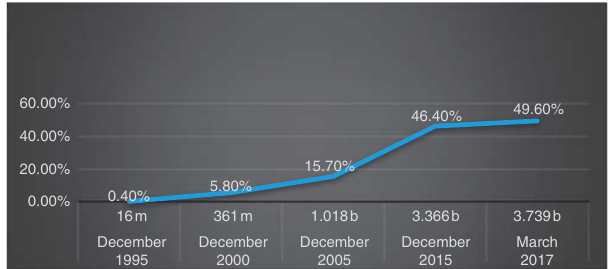
Figure 1. Percentage